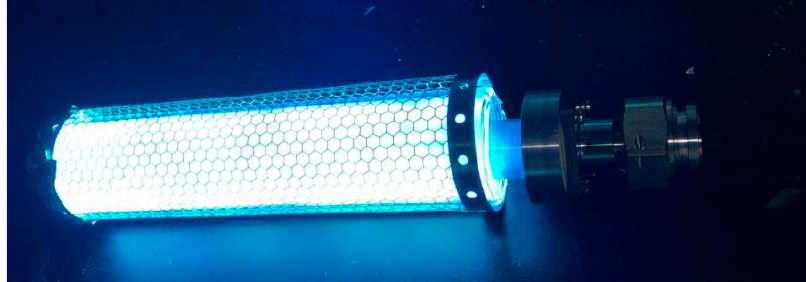
Figure 14. Experimental setup.